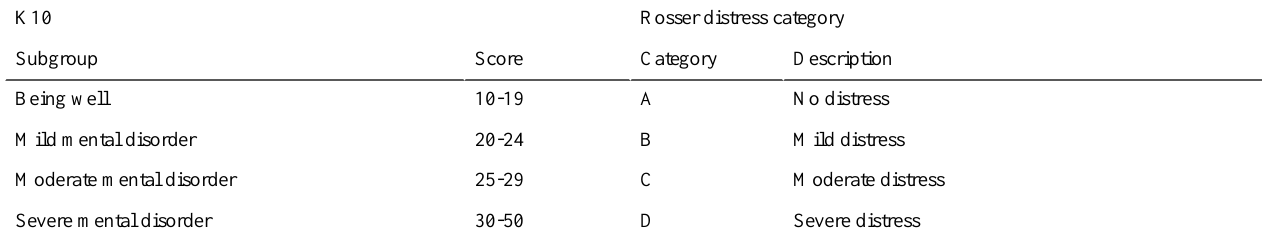
Table 2. Kessler Psychological Distress Scale (K10) scores and their corresponding Rosser distress